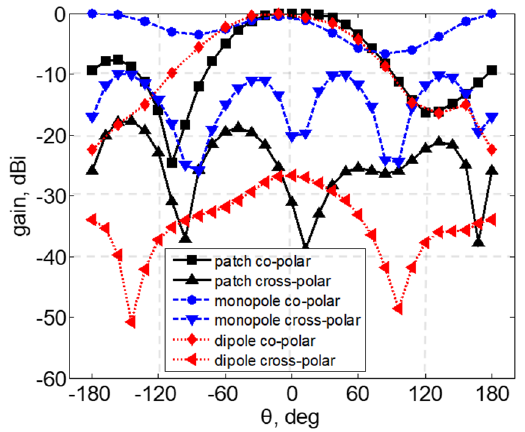
Figure 10. Co-polarization and cross-polarization components of the three antenna arrays.